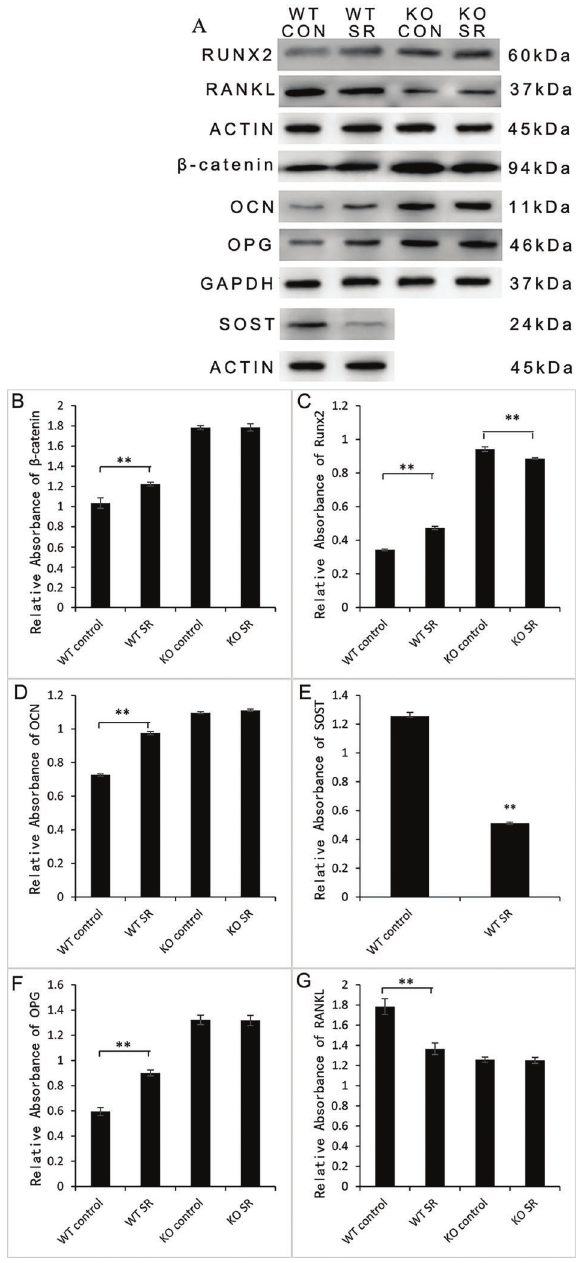
Figure 5. Western blot analysis of proteins in bone tissue sur- rounding the implant. The results are reported as the ratio of the target protein to the internal control ( b -actin). The data are reported as means ± SD of three experiments. A : western